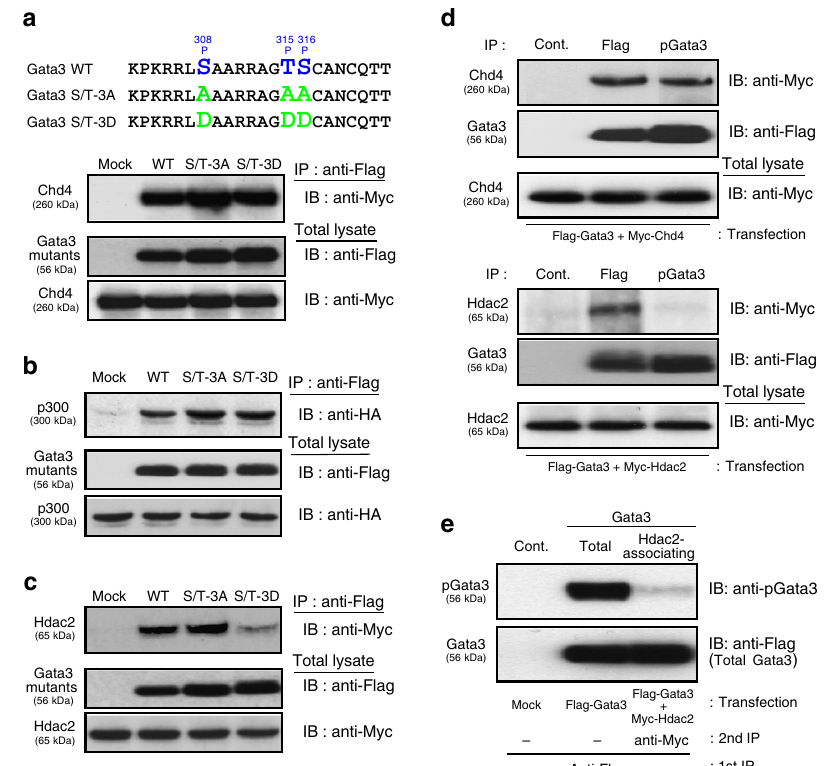
Figure 2 | Phosphorylation of Gata3 induces dissociation of Hdac2 from the Gata3 complex. ( a ) Comparison of the amino-acid alignment of Gata3 around phosphorylated Ser/Thr residues between WT and mutants (Gata3 S/T-3A: phospho-impaired, S/T-3D: phospho-mimic) are shown (Top panel). The amounts of Myc-tagged Chd4 associated with Flag-tagged Gata3 mutants were assessed as in Fig. 1a. ( b ) The amounts of HA-tagged p300 associated with Flag-tagged Gata3 mutants were assessed. ( c ) The amounts of Myc-tagged Hdac2 associated with Flag-tagged Gata3 mutants were assessed. ( d ) Total lysates from Flag-tagged Gata3 and Myc-tagged Chd4 (upper panel) or Hdac2 (lower panel) expressing 293T cells were subjected to IP with anti-Flag mAb or anti-phospho-Gata3 Ab followed by IB with anti-Flag or anti-Myc mAb. Total lysates were also subjected to IB in parallel. ( e ) Total lysates from Flag-tagged Gata3 and Myc-tagged Hdac2-expressing 293T cells were subjected to an initial IP with anti-Flag mAb followed by a second IP with anti-Myc mAb. The immunopurified total Gata3 and Hdac2-associating Gata3 were subjected to IB with anti-phospho-Gata3 Ab or anti-Flag mAb. Four ( c ), three ( a , b , d ) and two ( e ) independent experiments were performed with similar results. NATURE COMMUNICATIONS|7:11289|DOI: